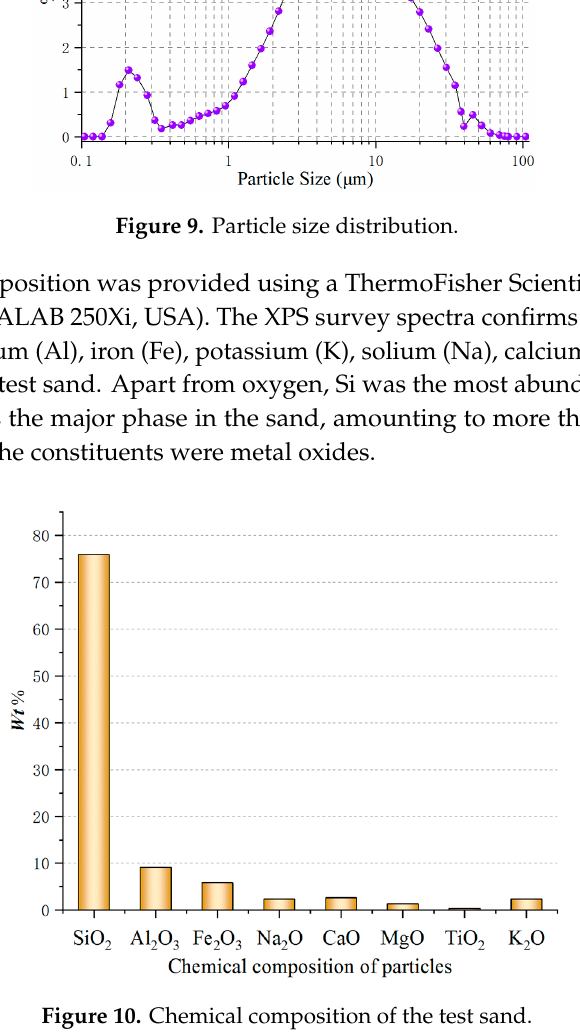
Figure 8. SEM image of test sand particles.